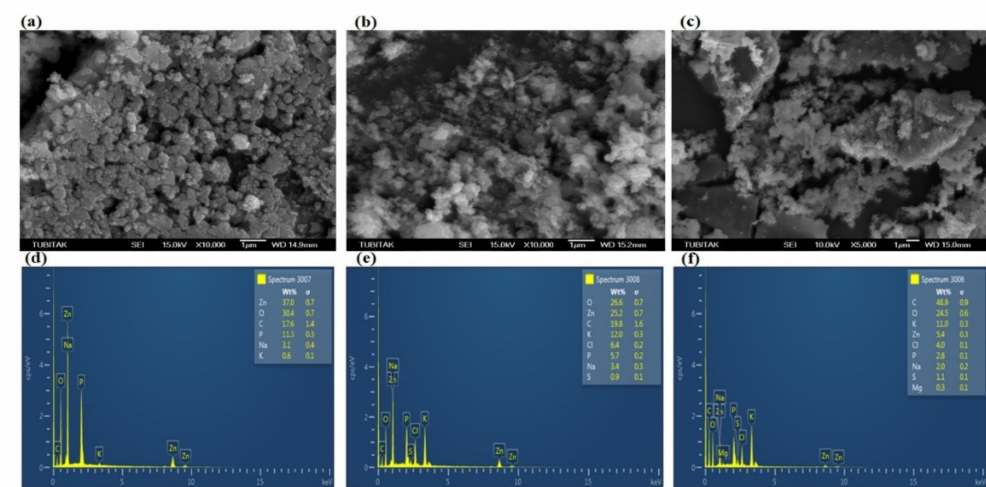
Figure 8. SEM images of biosynthesized ZnO NPsAL: ( a ) 0.1 M, ( b ) 0.05 M, and ( c ) 0.01 M. EDX spectra of the ZnO NPs: